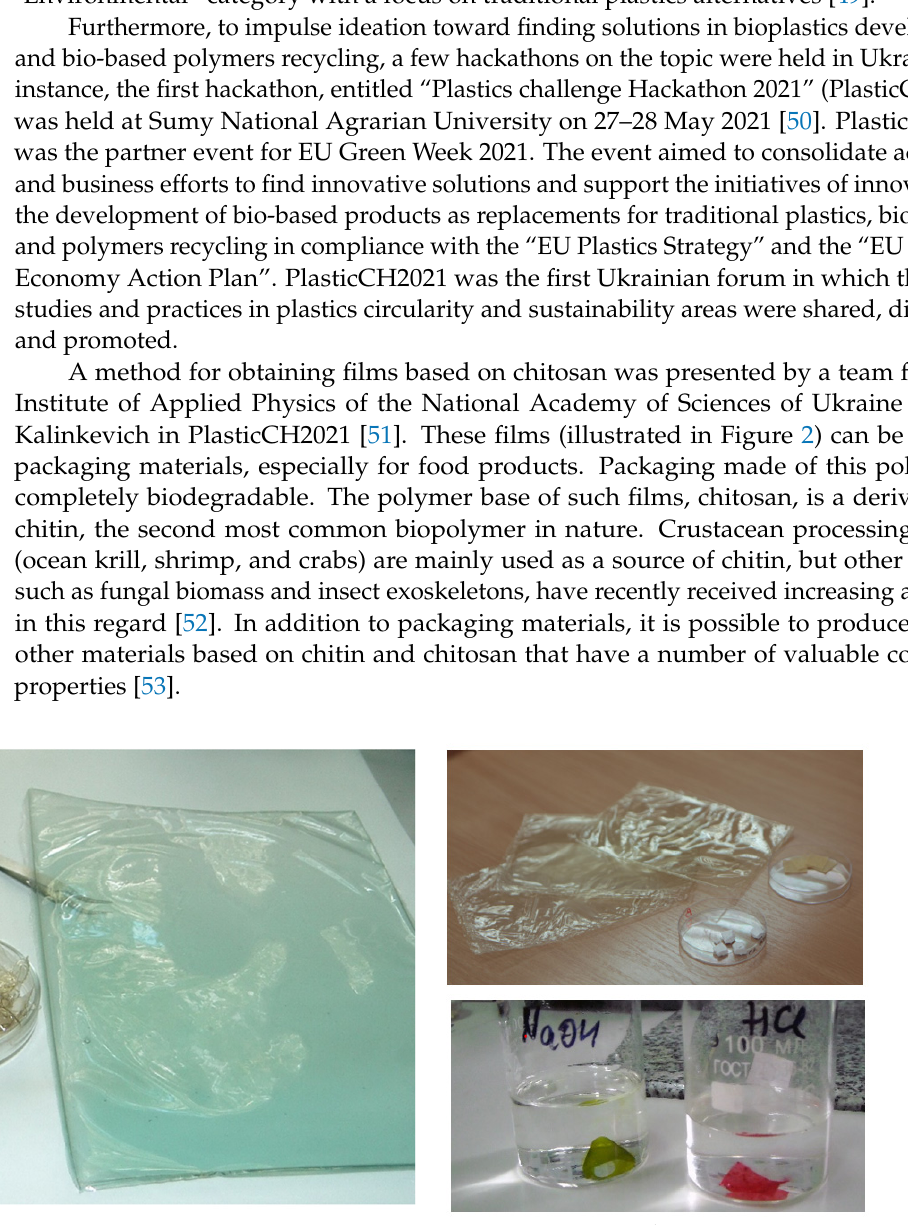
( b ) Figure 3. Mycelium-based biodegradable polymers: ( a ) flowerpot made from mycelium ( Open source photo ) [55]; ( b ) experimental sample of mycelium biopolymer ( Open source photo ) [56].